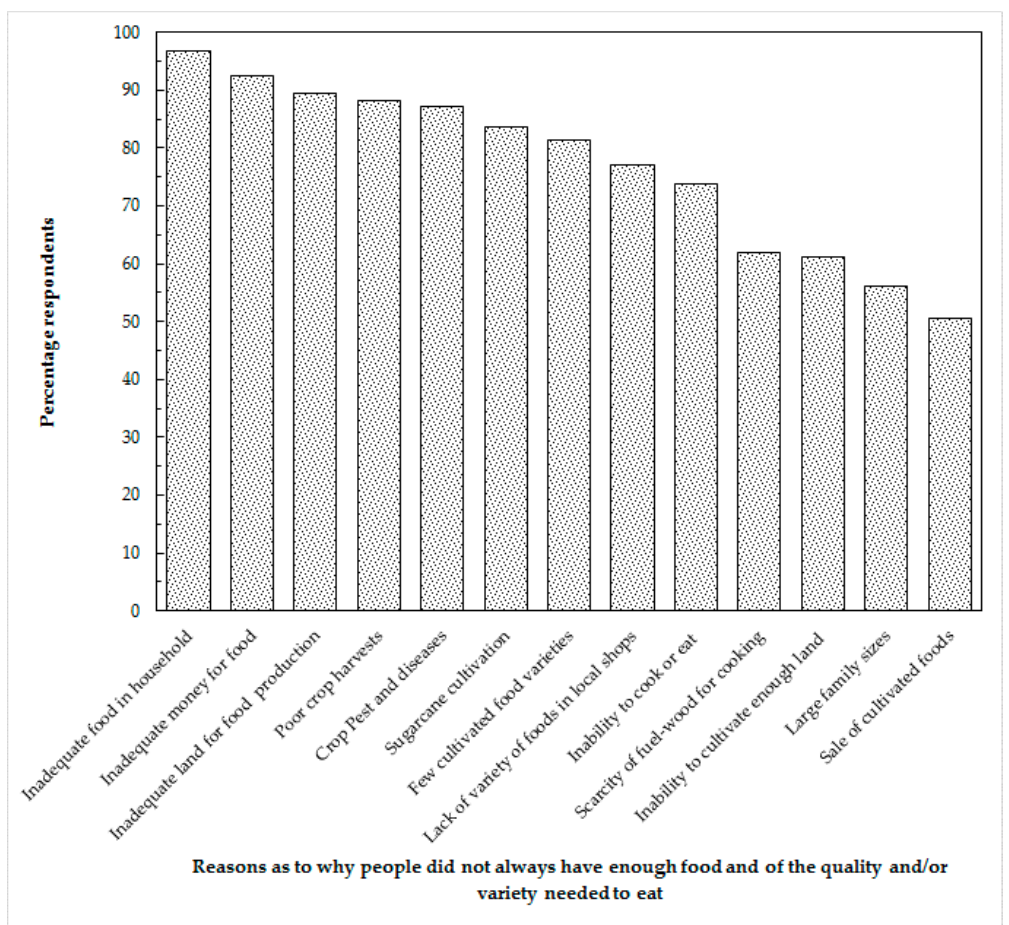
Figure 3. Reasons cited as to why people did not always have enough food and of the quality and/or variety to eat in the surveyed households in areas of commercial sugarcane cultivation of Mayuge and Jinja Districts, Eastern Uganda. (n = 208).